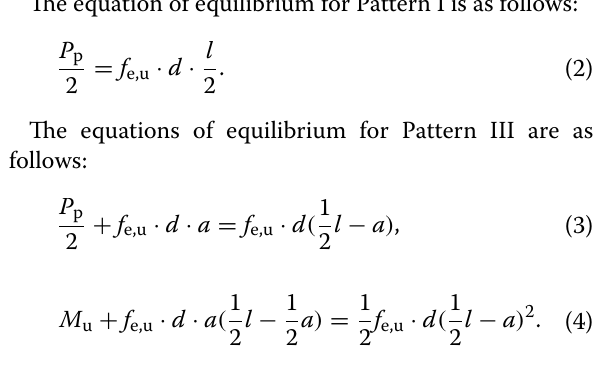
Fig. 8 Schematic for the process-wide force–displacement of a bolted joint